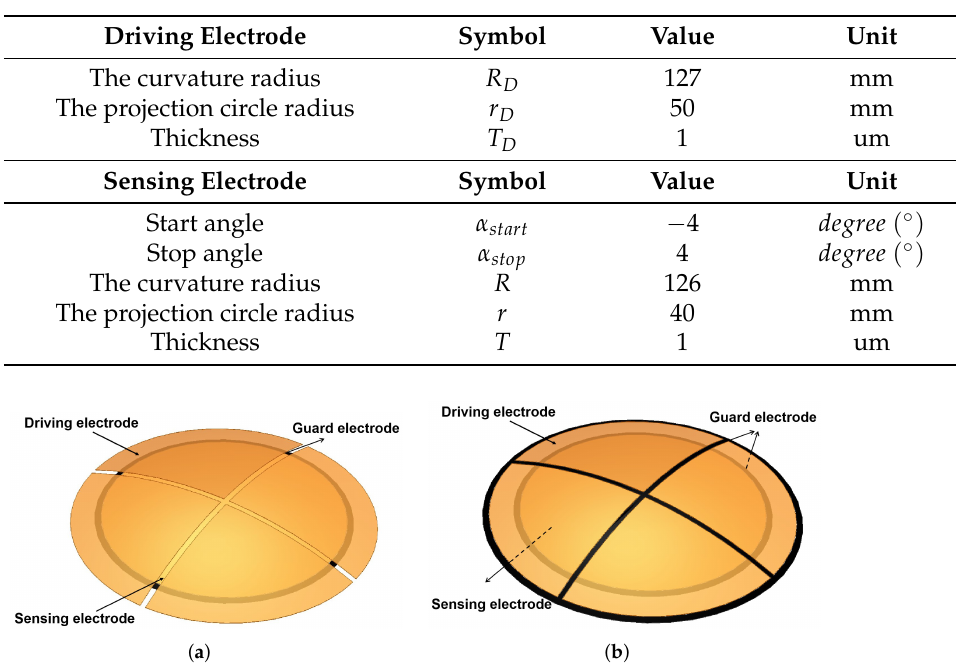
Table 1. Simulation model parameters of the capacitive sensor.